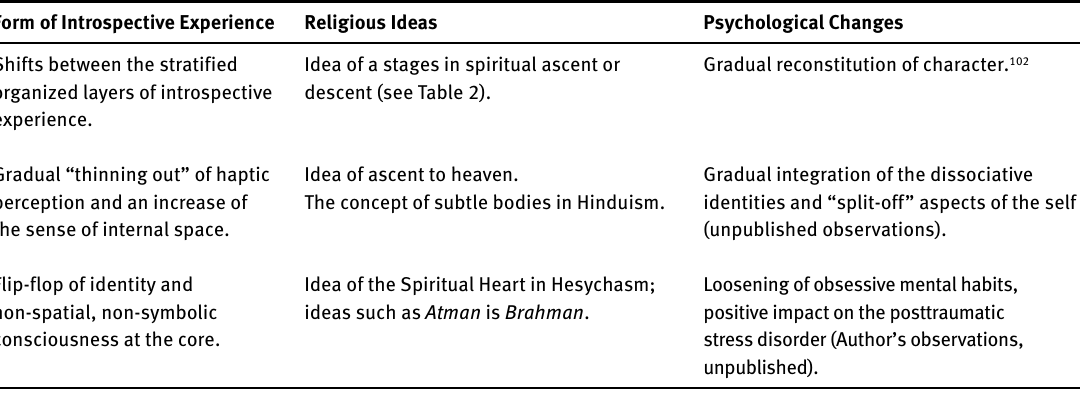
Gradual reconstitution of character.